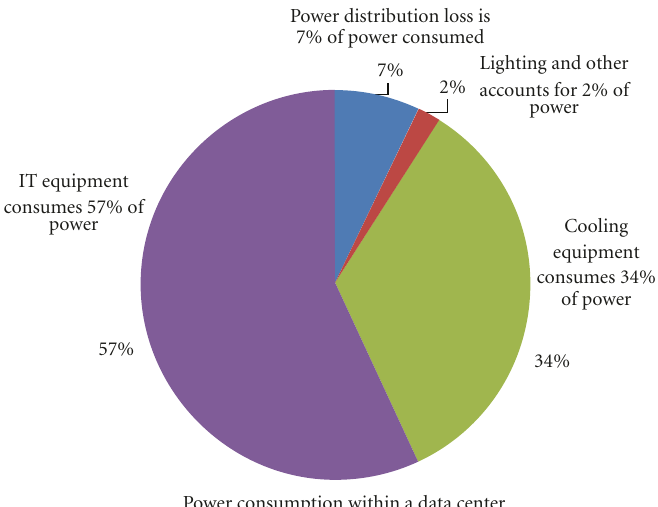
Figure 2: Power Consumption within a Data